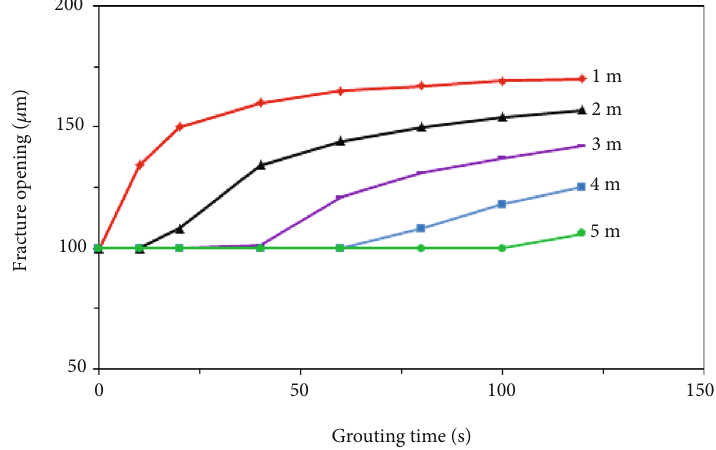
Figure 8: Curves of fracture opening vs. grouting